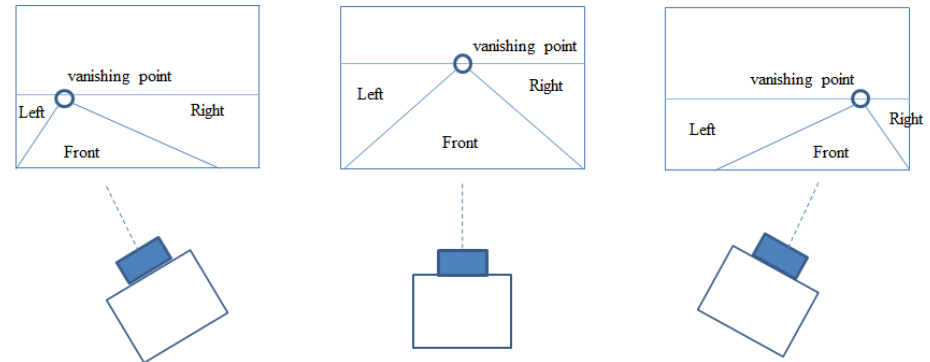
Figure 7. Classification of pedestrian’s location based on the vanishing point and two lines: The vanishing point and two lines move accordingly when the vehicle turns left or right.